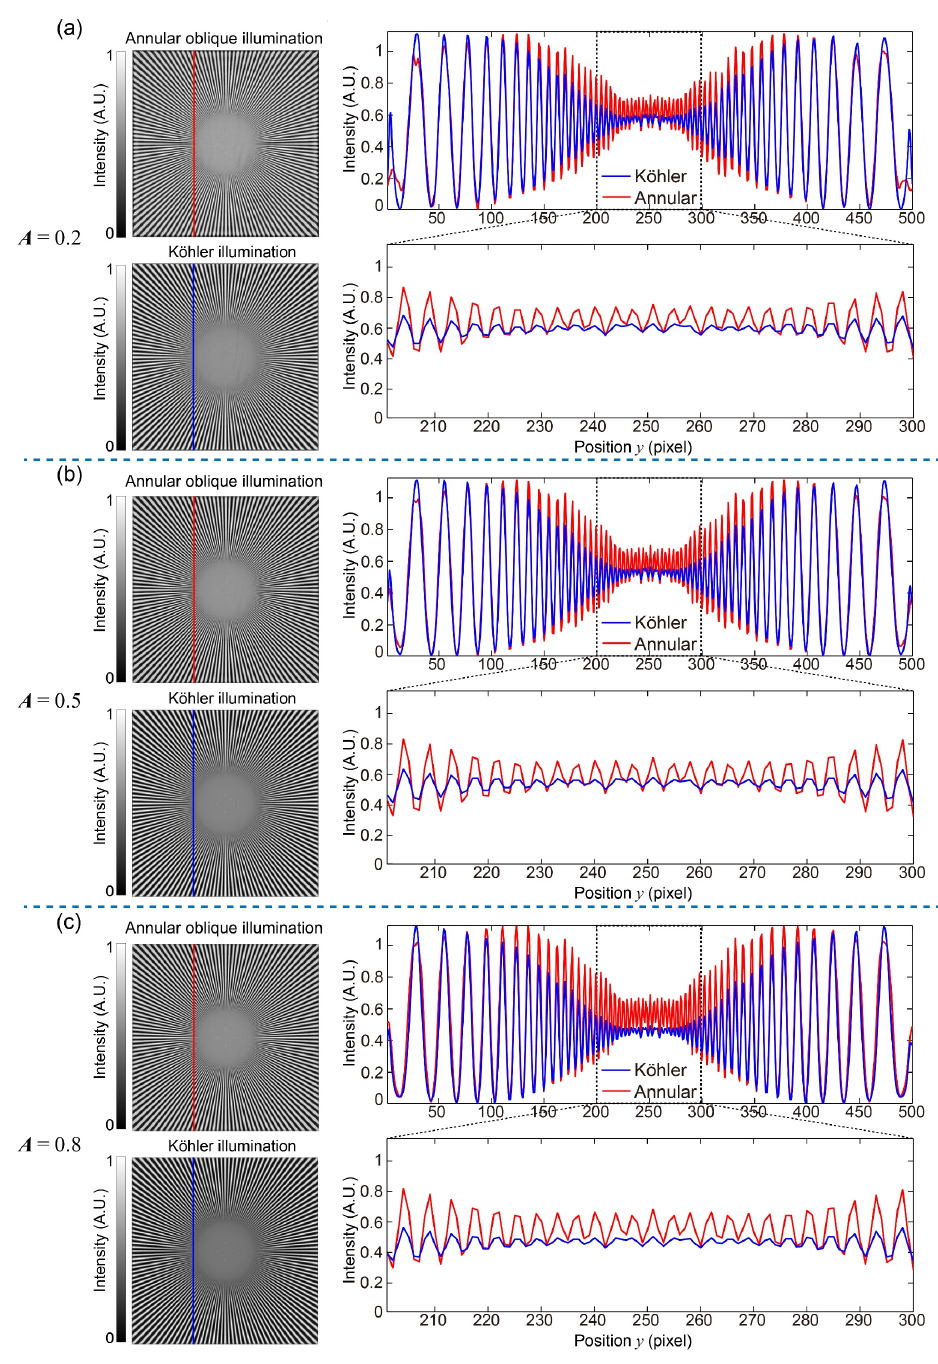
Figure 7. Deconvoluted images: ( a ) A = 0.2, simulated images with intensity distributions at the 170th column, and intensity distributions of 201 to 300 pixels at the 170th column; ( b ) A = 0.5, simulated images with intensity distributions at the 170th column, and intensity distributions of 201 to 300 pixels at the 170th column; ( c ) A = 0.8, simulated images with intensity distributions at the 170th column and intensity distributions of 201 to 300 pixels at the 170th